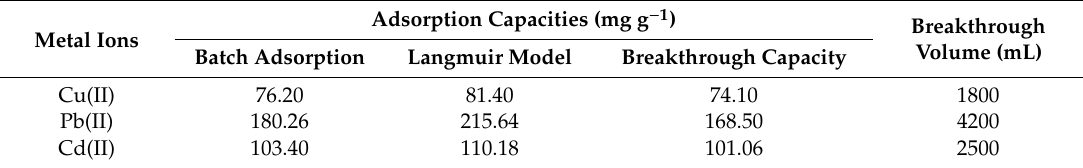
Table 4. Metal ions adsorption capacity of APBC by batch and continuous column methods. Metal Ions